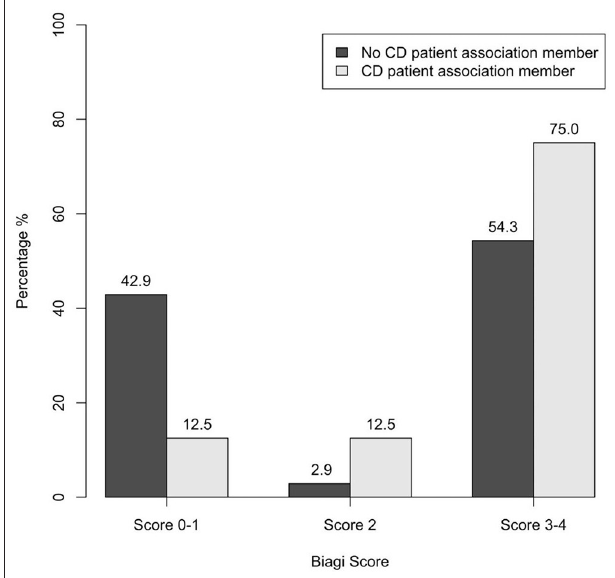
FIGURE 4 | Follow-up of the SC-group and of the CF-group (three-modality follow-up analysis) ( p < 0.001). SC, screen-detected (group); CF, case-finding (group); CD, celiac disease.